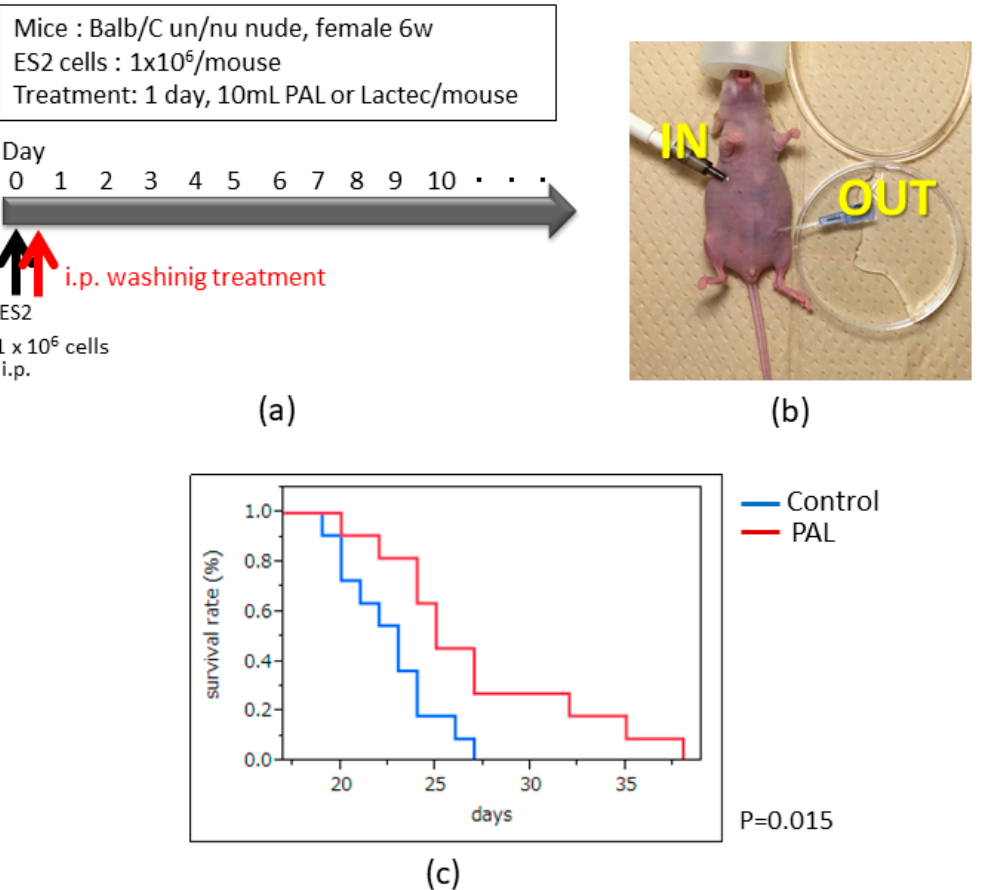
Figure 5. Effect of plasma-activated Ringer’s lactate solution (PAL) washing therapy on intraperitoneal metastasis in the ovarian cancer mouse model. ( a ) Outline of PAL washing therapy in the model. ( b ) The perfusion route during the therapy. ( c ) Survival analysis by the Kaplan–Meier method in the PAL washing and control groups ( p < 0.05, n =